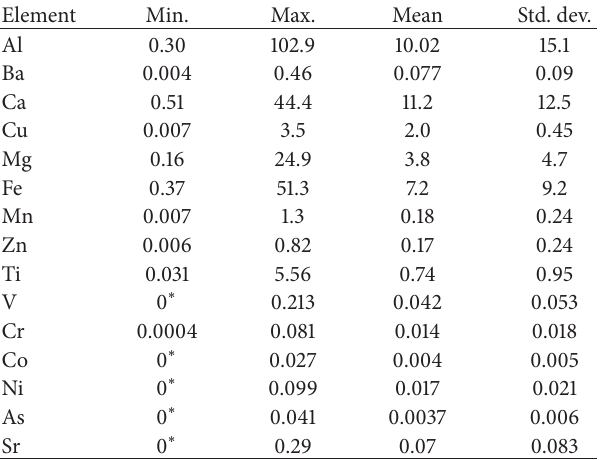
Table 2: Minimum and maximum measured concentrations in TSP samples ( 𝜇 g/m 3